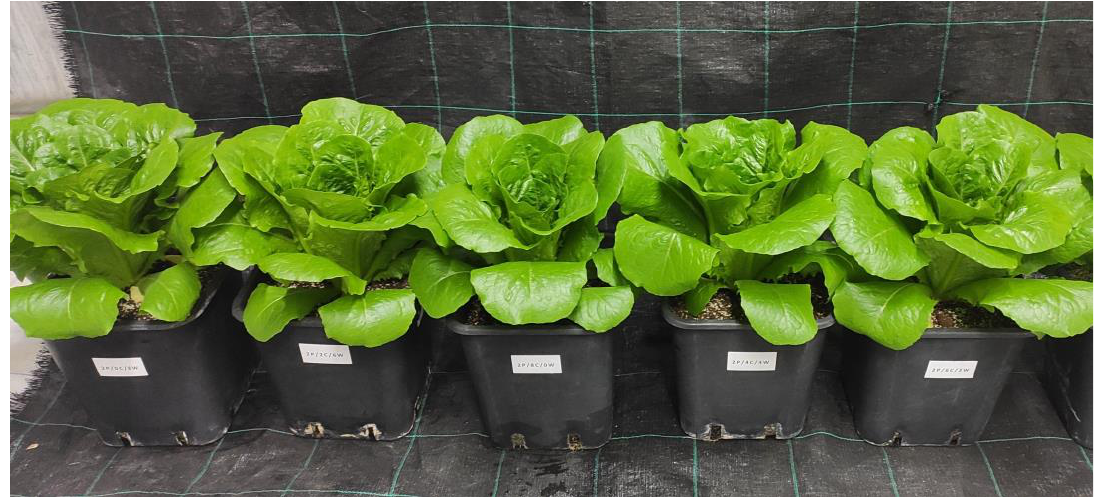
Figure 4. Treatment samples on DAT35. From left to right 8W, 2C:6W, 8C, 4C:4W, 6C:2W. Treatment names in the photograph include 2P to denote perlite fraction.